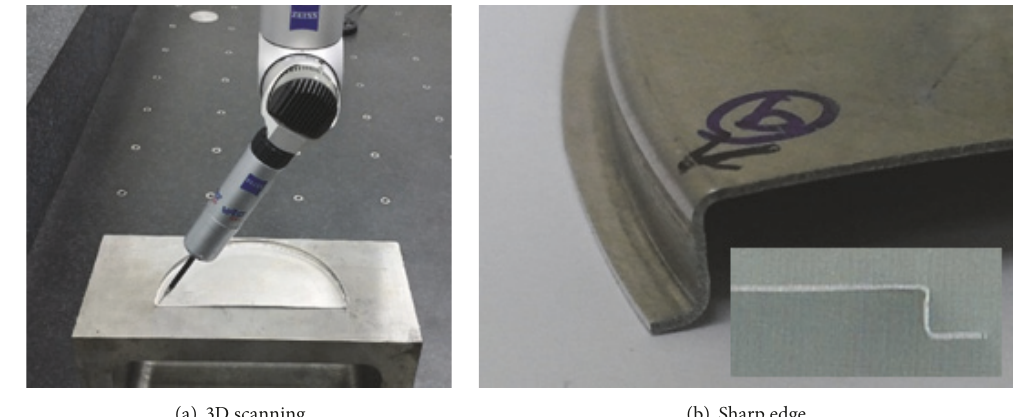
Figure 12: 3D scanning and forming part with sharp edge.